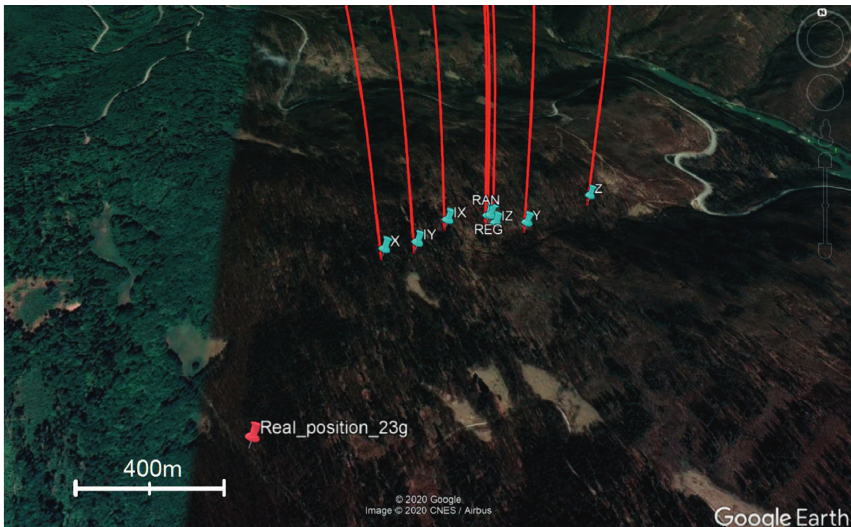
Figure 11: Detail on the impact area for the individual modeled orientations. On the left, the location of the fragment no. 53 (red) is recovered and it is equivalent to spherical model position. The impact area is located outside the line which brings together the fragment’s direction of flight and real impact